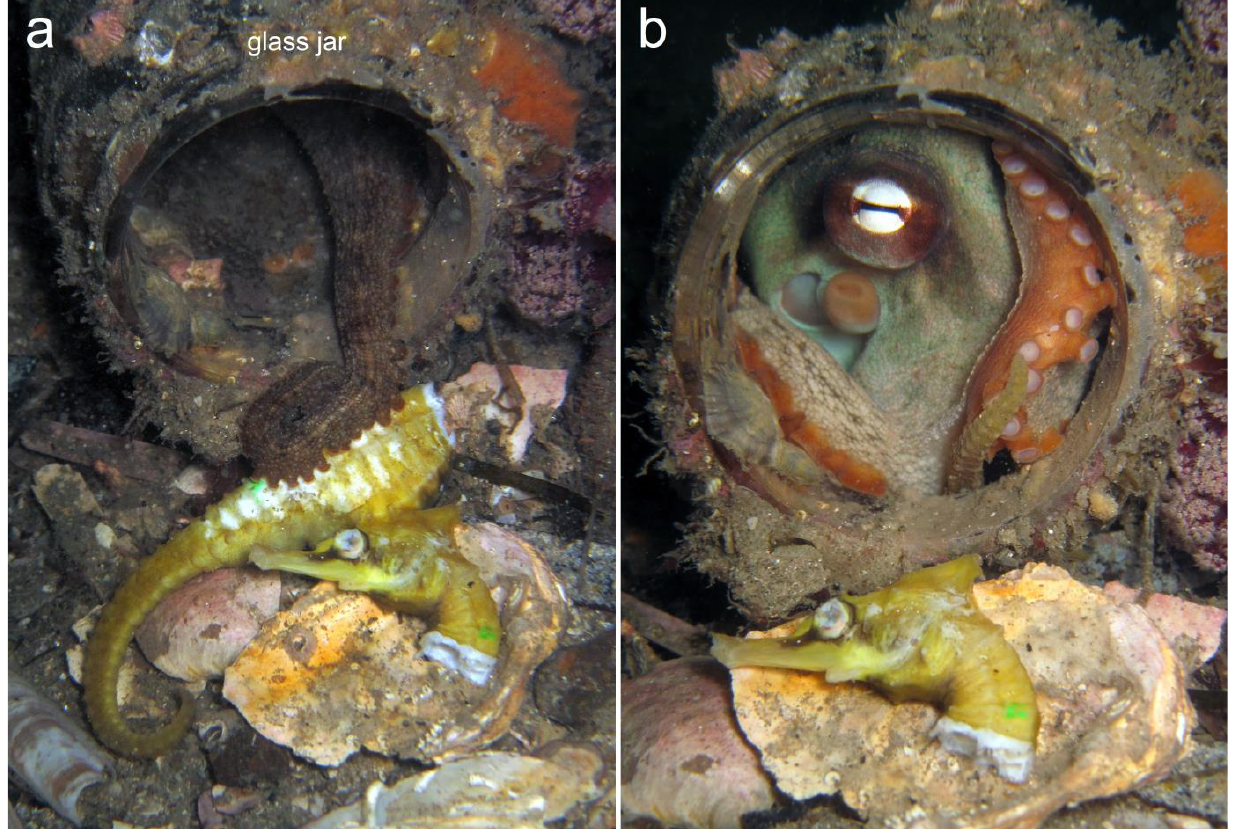
Figure 2. An individual of Hippocampus whitei bitten and partly consumed by a common Sydney octopus ( Octopus tetricus ) at Port Stephens (NSW, Australia). The octopus is hiding inside a discarded glass jar. ( a ) Separate head and tail parts of the seahorse in front of the jar. ( b ) The tail part has disappeared. Green spots: elastomer tag dating from 2007. Photo credit: David Harasti. The third example is from the same area and the same research project as the former.